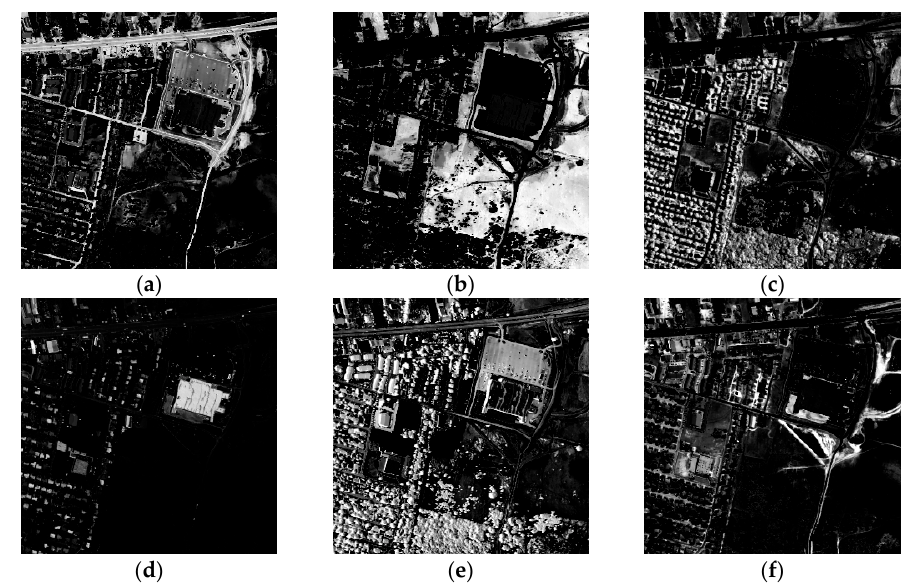
Figure 9. Abundance maps of endmembers estimated by BF- L 2 SNMF on the urban data set: ( a ) asphalt, ( b ) grass, ( c ) trees, ( d ) rooves, ( e ) metal, and ( f ) dirt. AVIRIS Cuprite Data Set: The Cuprite data contained 224 bands that covered a wavelength range from 0.4–2.5 µm. A total of 187 effective bands remained after removing the low SNR bands. A region of 250 191 × was cut out for the experiment, and the false-color image is shown in Figure 10a. The reference endmember spectra could be obtained in the USGS spectral library [50]. Figure 10b shows the reference mineral distribution of the region that was provided by the USGS in 1995.